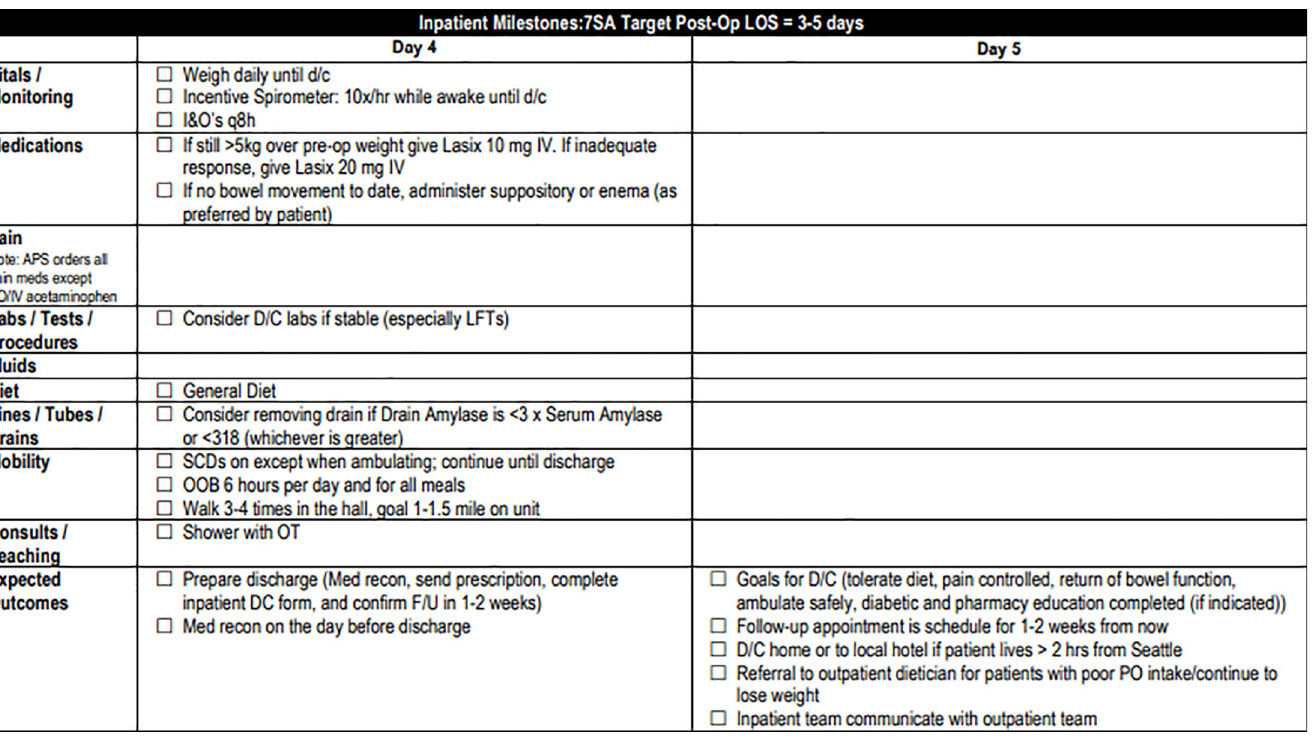
Fig 5. Whipple Post-operative Pathway Days